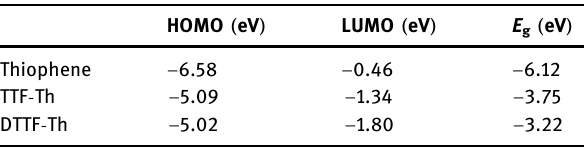
Table 3: Theoretical calculated HOMO/LUMO energies and band gap of TTF - Th and DTTF -